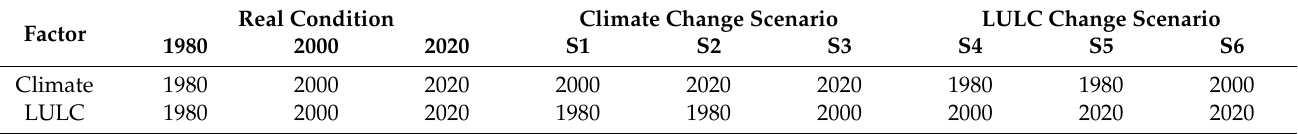
Table 2. The scenario settings of climate change and LULC